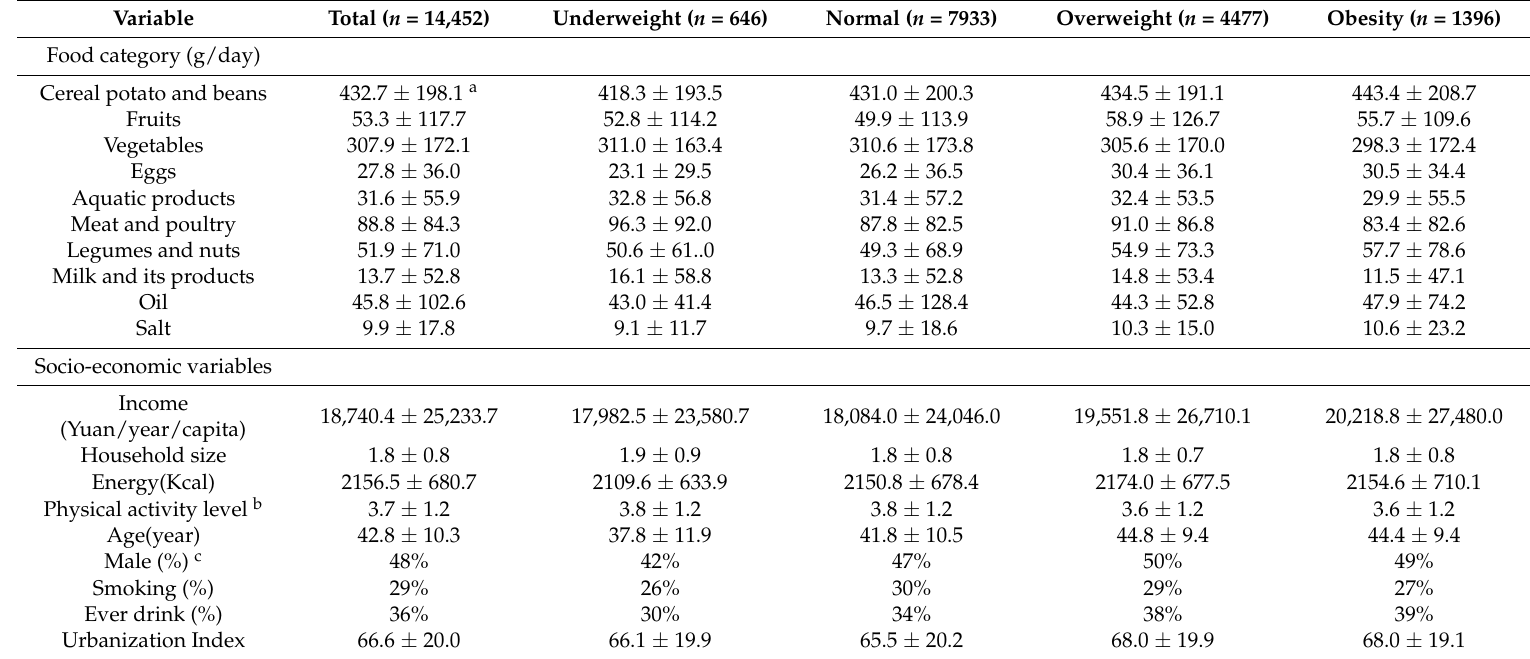
Table 1. Characteristics of